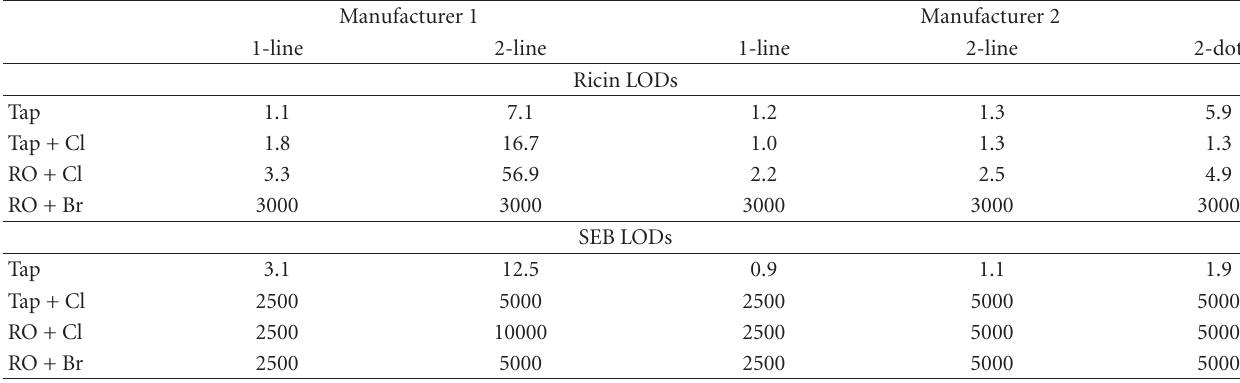
Table 1: LODs a or ricin and SEB in multiple water matrices using handheld assays.